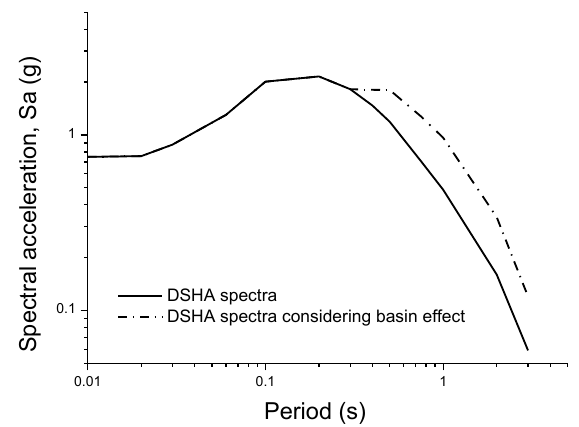
Figure 15. The basin effect in Taipei (site a) on response spectra; the spectra scaling follows the suggestions of Solokov et al. (2009,